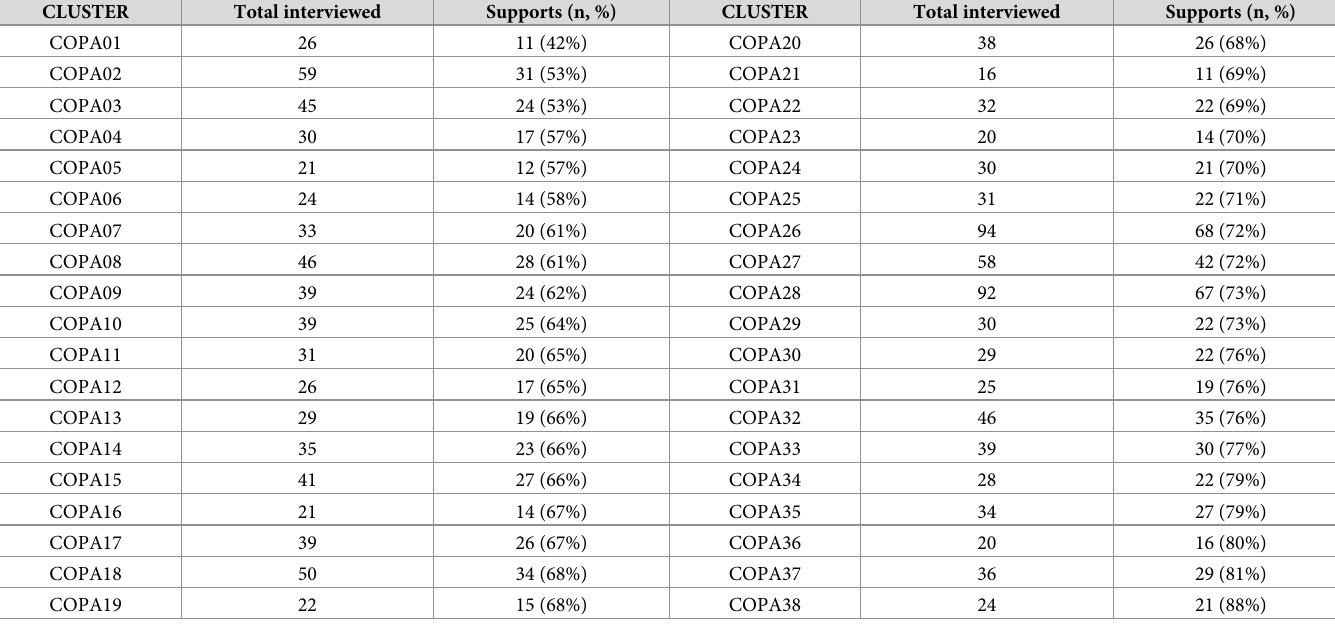
Table 3. Wolbachia Suppression support by cluster, COPA cohort baseline survey, Ponce, Puerto Rico, 2018–2019.